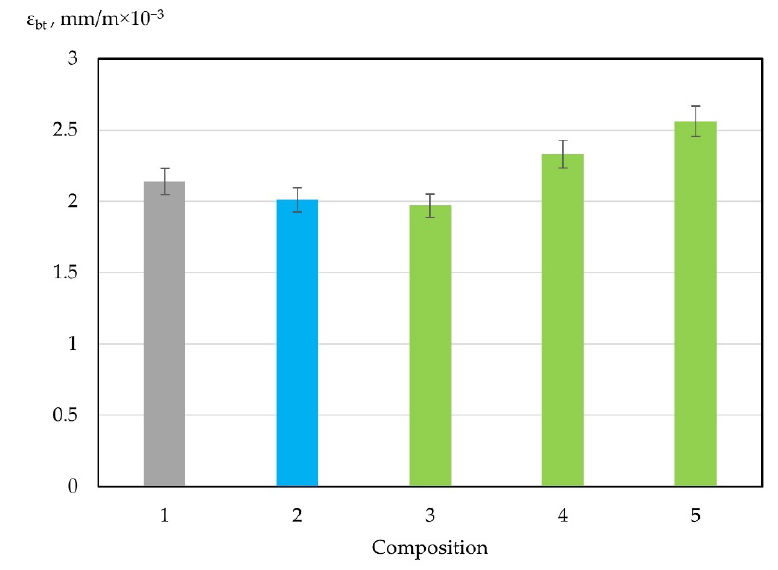
Figure 10. Change in ultimate strains under axial compression of concrete samples at the age of 28